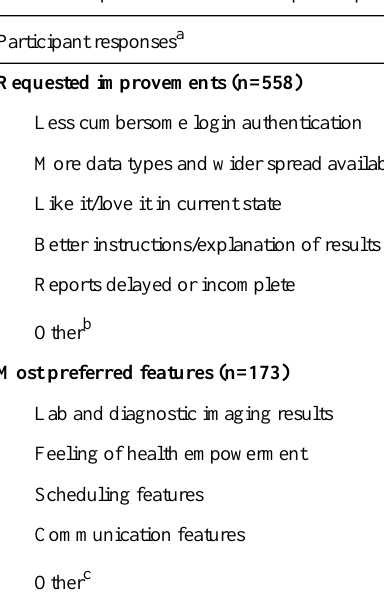
Table 2. Respondents’view on the patient